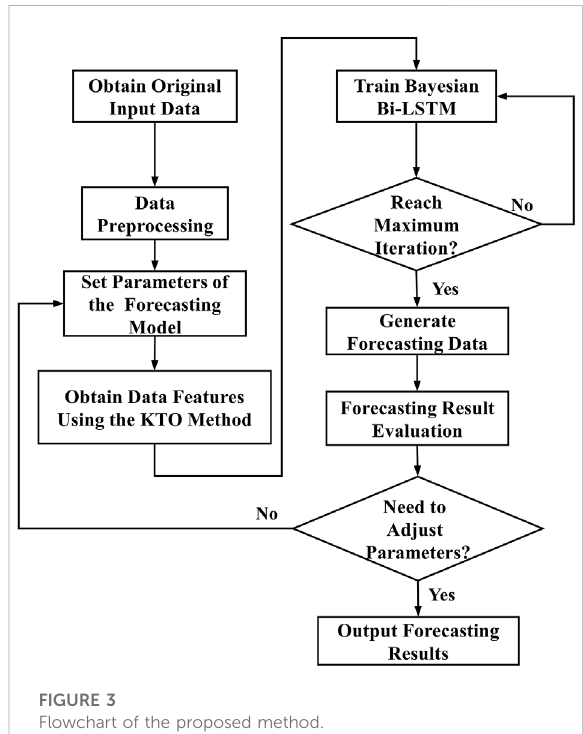
FIGURE 3 Flowchart of the proposed